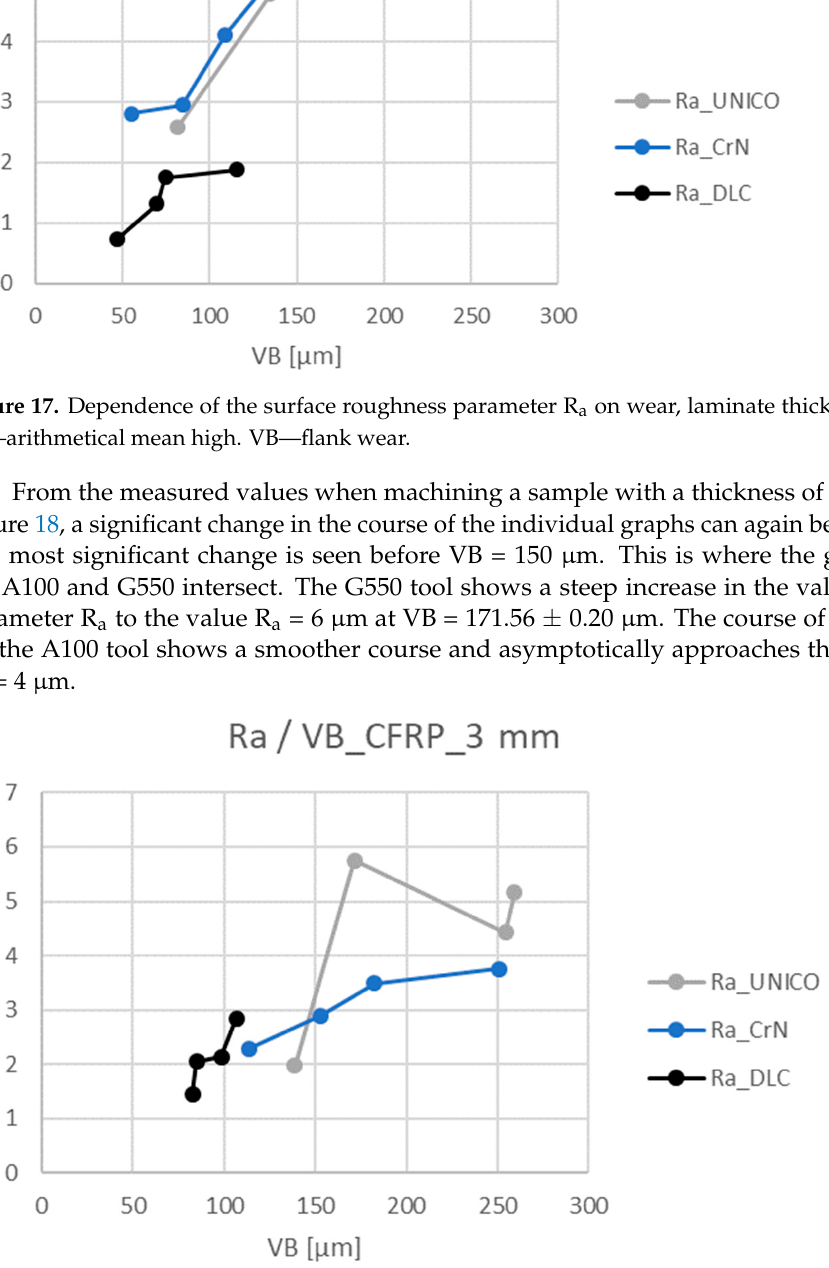
Figure 18. Dependence of the surface roughness parameter R a on wear, laminate thickness 3 mm. R a —arithmetical mean high. VB—flank wear.